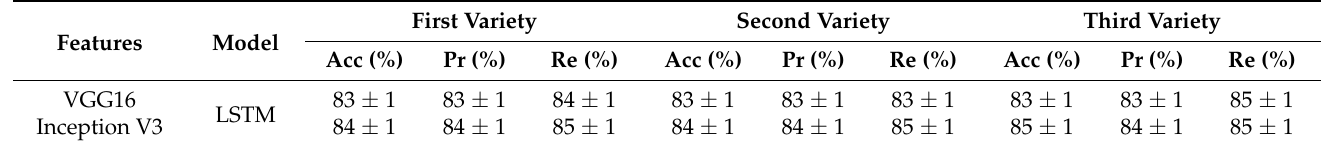
Table 6. Test results of 5-level classification of yield production.